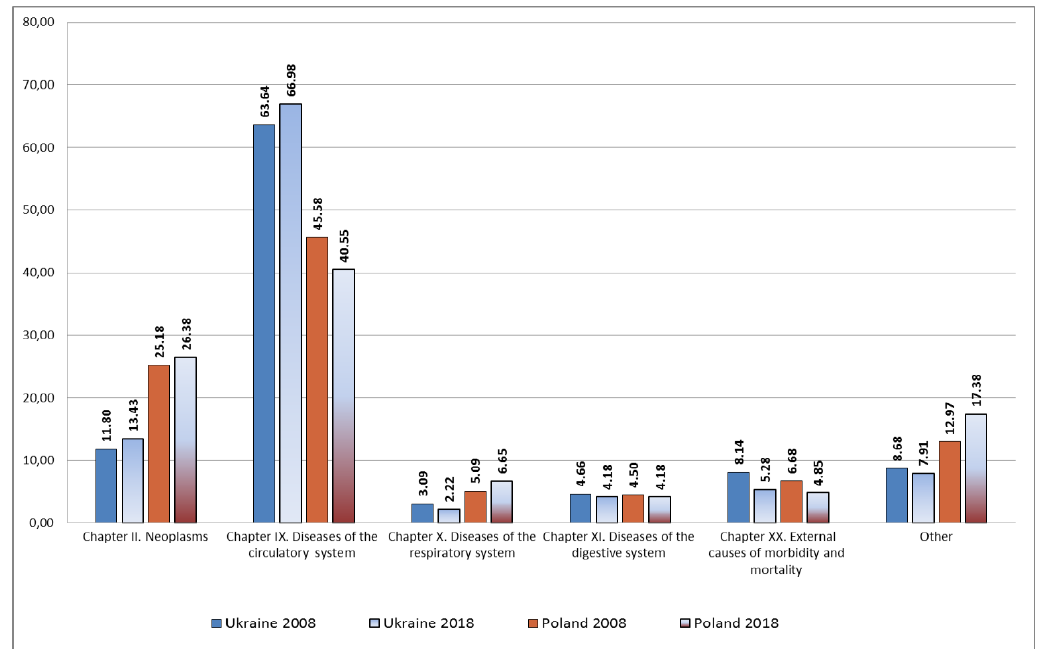
to respiratory diseases (+1.57%), tumors (+1.21%), endocrine diseases, eating disorders, of the nervous system (+0.27%) all increased.